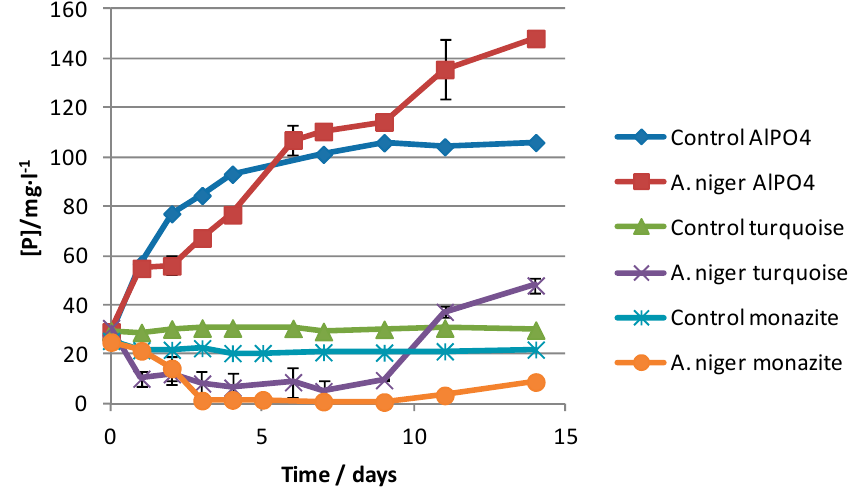
Figure 1. Evolution of phosphorous concentration from different mineral phosphates (aluminum phosphate, turquoise and monazite) at 1 g/L in abiotic and biotic ( A. niger ) tests.